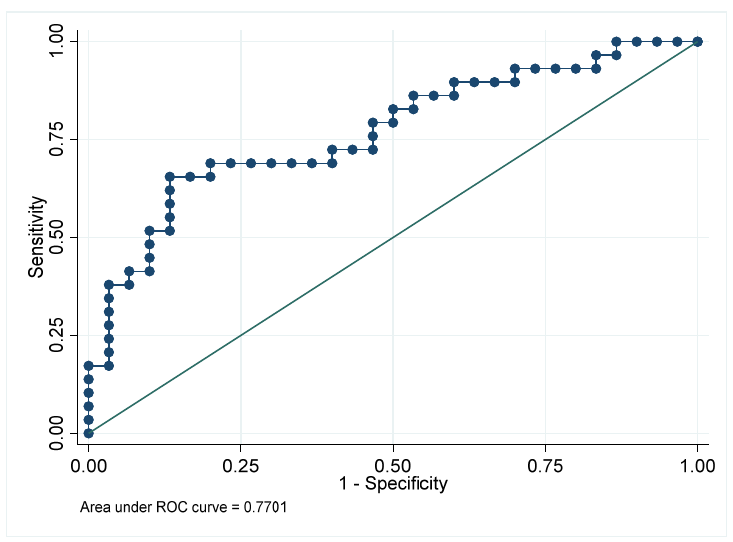
Figure 2. ROC curve for model 6. Source: Own estimation based on STATA 16.0.